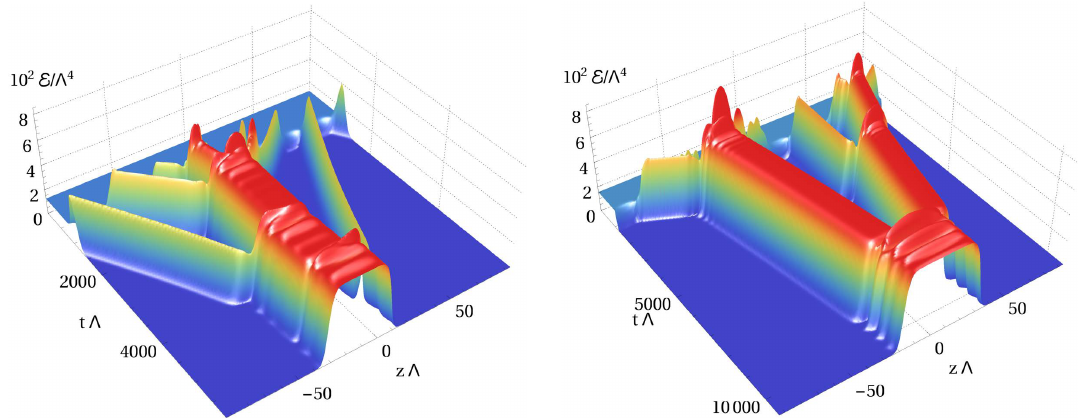
Figure 5 . Time evolution of two different merger with φ M = 2 . 3 and L z Λ ’ 187 longitudinal extent: (left) Spacetime evolution E ( t = 0) = E 1 and with initial n = 1 perturbation up to t Λ = 5885 ; (right) Spacetime evolution E ( t = 0) = E 2 and numerical noise as initial perturbation up to t Λ = 10700